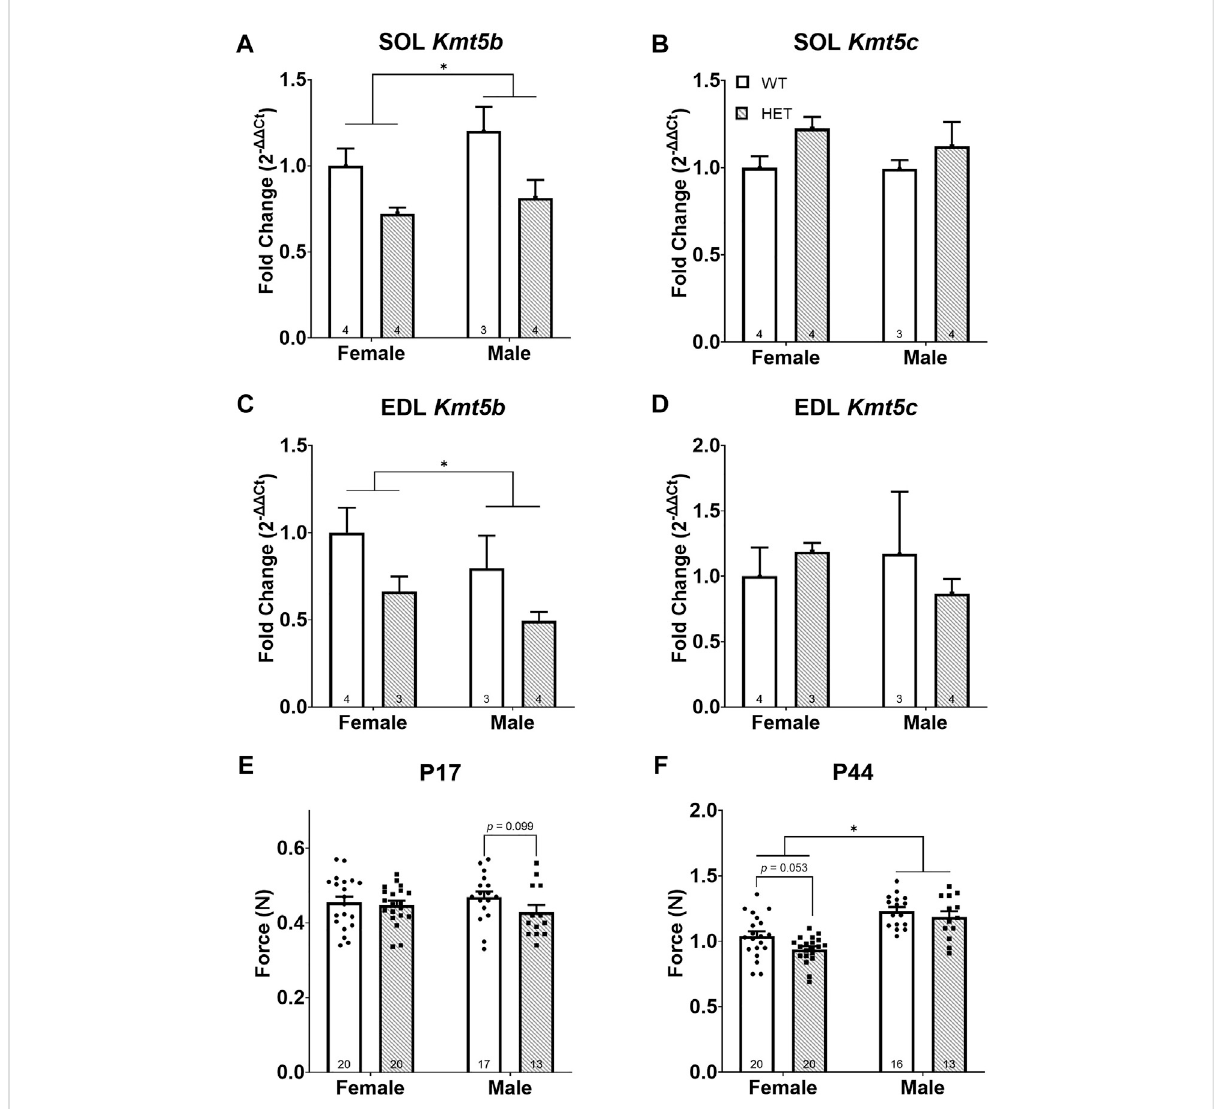
FIGURE 1 Kmt5bHET miceshowaprogressivestrengthde fi cit.Geneexpressionof Kmt5b (A,C) and Kmt5c (B,D) measuredbyqRT-PCRshownforsoleus [SOL; (A,B)] and extensor digitorum longus [EDL; (C,D)] muscles at postnatal day (P) 17. Results of pull bar strength testing are shown collected at P17 (E) and P44 (F) . WT : dots and open bars; HET : squares and grey hatched bars. * p < 0.05; (2-way ANOVA). p -values shown are the results of post hoc testing. Error bars show ±SEM; number of biological replicates are shown within each